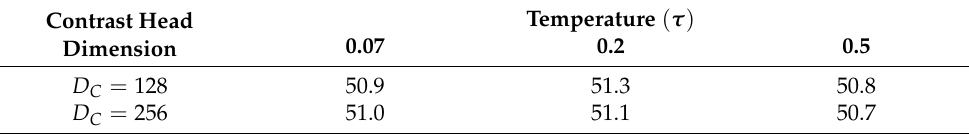
Table 3. Ablation for contrastive hyper-parameters, results from 10 shot of the proposed method. Contrast